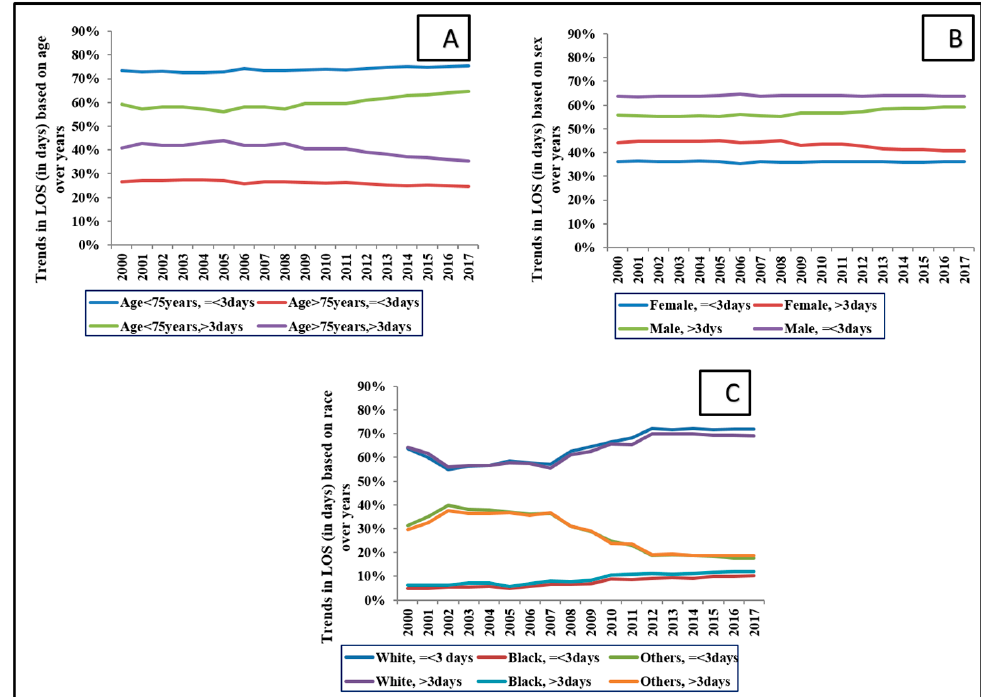
Figure 2. Temporal trends of LOS (in days) based on patient characteristics. Legend: Percentage of AMI admissions with LOS based on age ( A ), sex ( B ), and race ( C ). Abbreviations: AMI: acute myocardial infarction, LOS: length of stay.